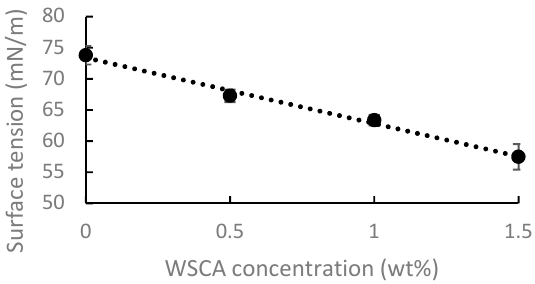
Figure 6. The e ff ect of WSCA concentration on surface tension of water. Figure 6. The effect of WSCA concentration on surface tension of water. Figure 6. The effect of WSCA concentration on surface tension of water.